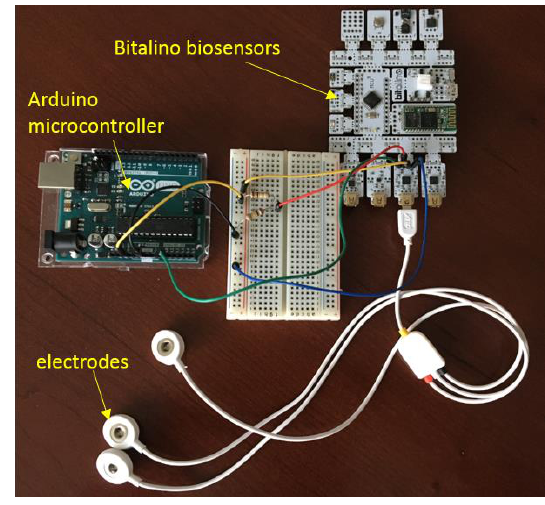
Figure 3. Prototype experimental setup.